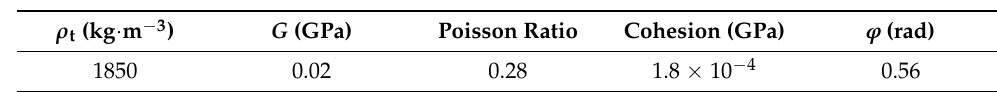
Table 6. Parameters of tamping